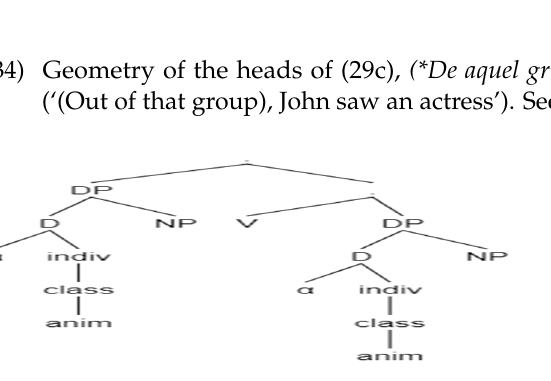
Figure 25. Geometry of the Phi label.